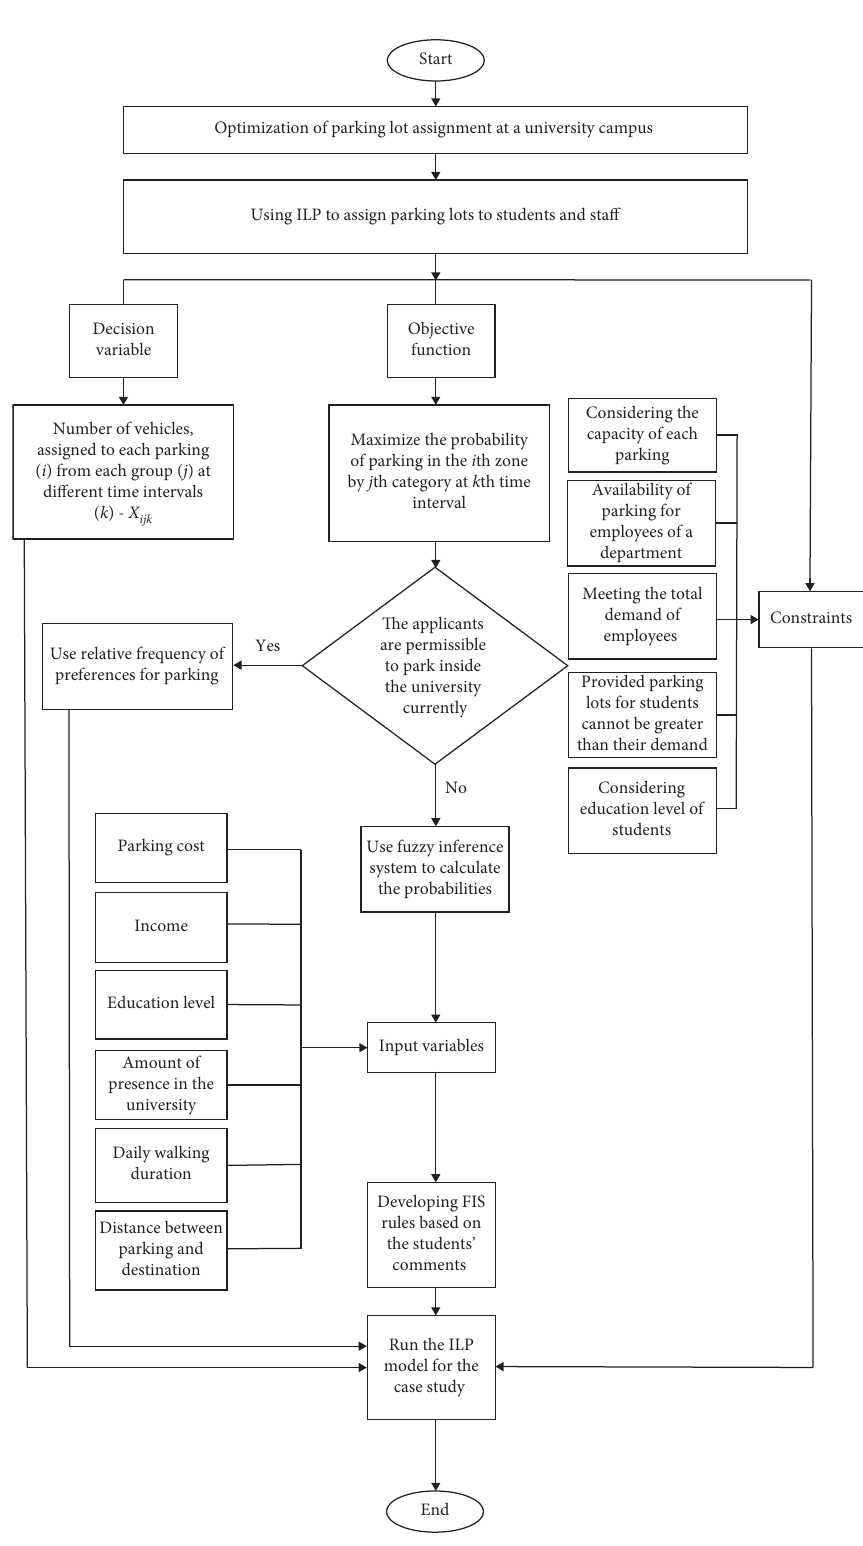
Figure 2: Research